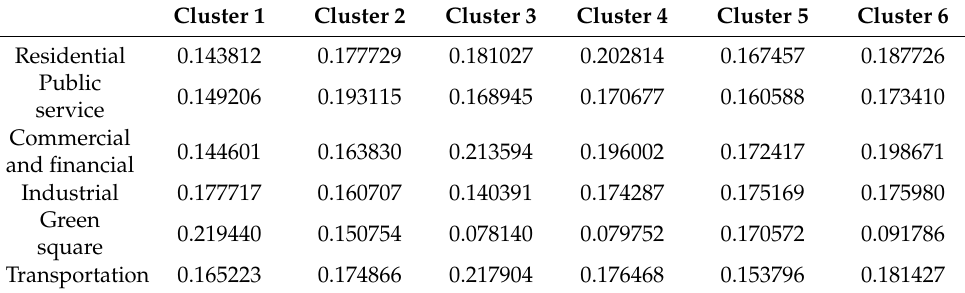
Figure 6. Map of UFR identification results. Table 3. CP values of different clustering regions (clusters 1–6).